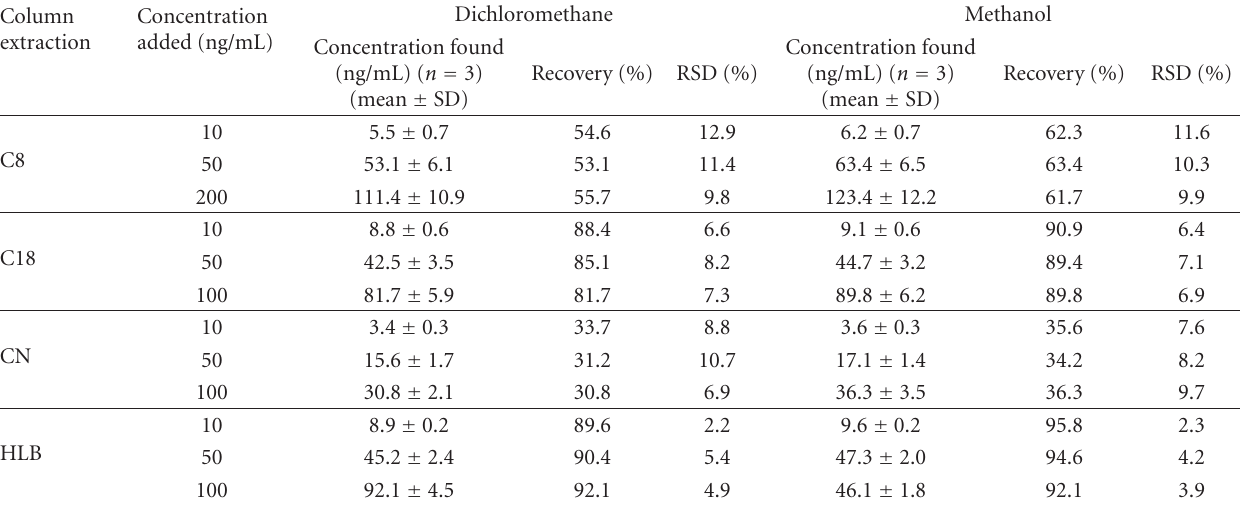
Dichloromethane Methanol Column Concentration extraction added (ng/mL) Concentration